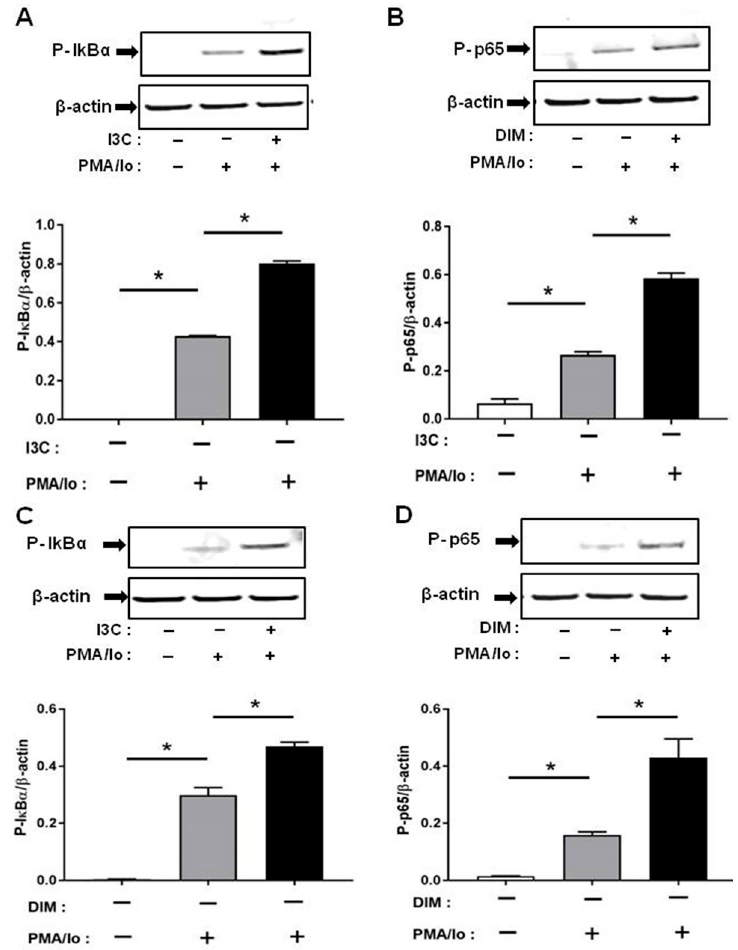
Figure 4. Effects of I3C, DIM on Nuclear Factor κ B (NF- κ B) activation in Jurkat cells. Jurkat cells were treated with 50 µ M of I3C or 10 µ M of DIM for 48 h and then stimulated with PMA + ionomycin for 10 or 30 min. Cells were harvested for protein. ( A , C ) Phosphorylation levels of I κ -B α (ser32); and ( B , D ) Phosphorylation levels of Nuclear Factor κ B-p65 (NF- κ B-p65) (ser536) were determined by western blot analysis. Protein expression was normalized to levels of housekeeping gene ( β -actin). The inset shows representative Western blots. * indicates significantly different from control at p <